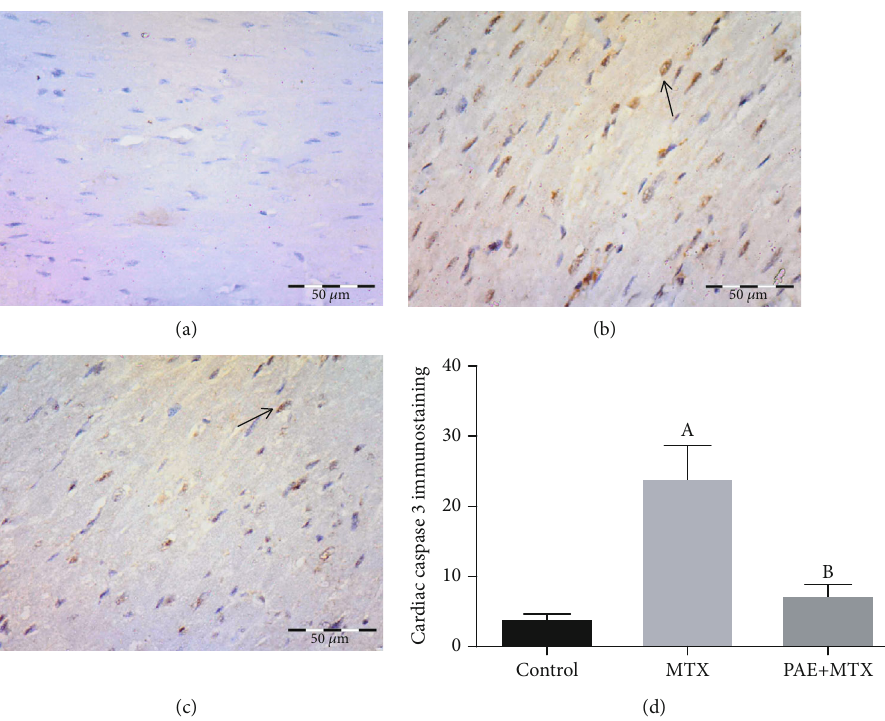
Figure 5: E ff ect of paeonol (PAE) on cardiac caspase 3 immunostaining in methotrexate- (MTX-) induced cardiac toxicity in rats. (a) Control group showing minimal expression. (b) MTX-treated group showing positive cytoplasmic and nuclear expression (arrow). (c) PAE+MTX group showing positive expression in scattered cells (arrow). (d) Semiquantitative analysis of the results. Values represent means ± SEM . “ A ” means signi fi cant di ff erence compared to the control group and “ B ” means signi fi cant di ff erence compared to the MTX-treated group, at p < 0 : 05